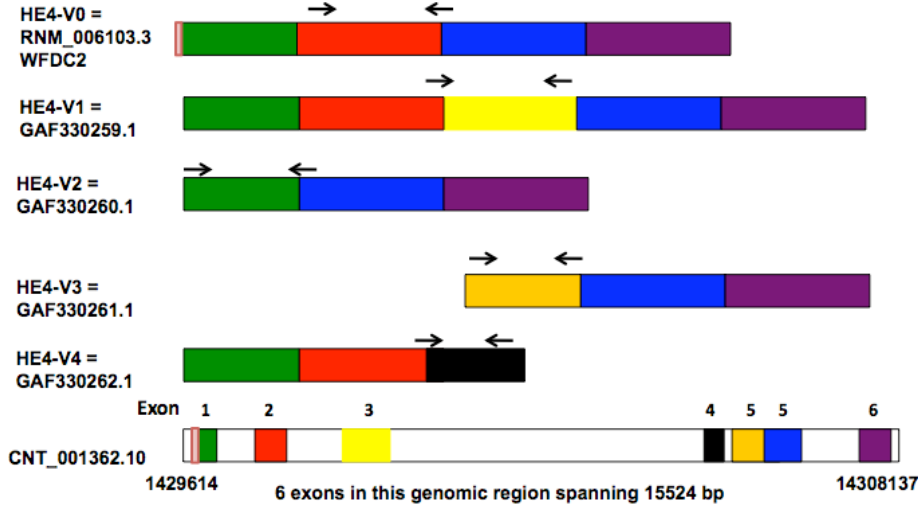
Figure 1. Schematic outline of real-time PCR primer design for each HE4 variant. The structures of HE4 variants were illustrated with the six exons marked in different colors. The locations of real-time PCR primers were indicated by arrows. On the bottom the HE4 shown based on the information from NCBI website [37]. The HE4 gene is located at